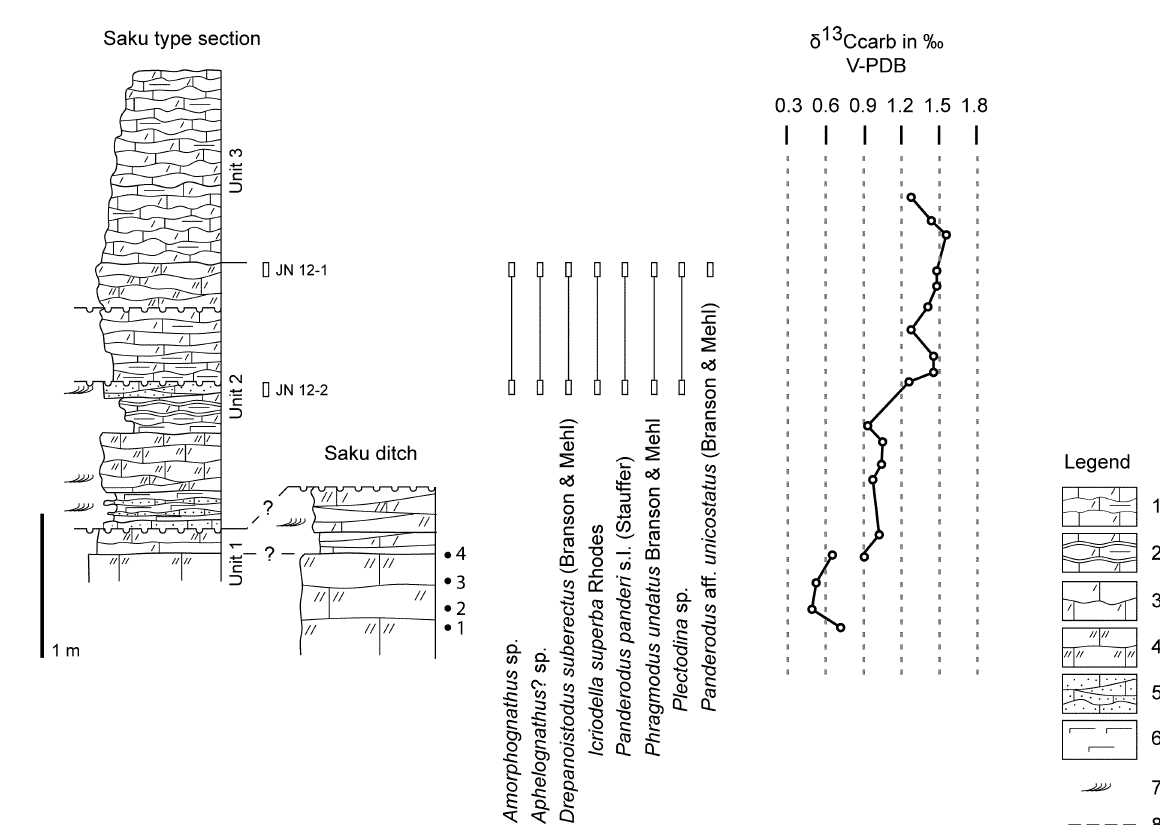
Fig. 4. General lithological logs of the type section of the Saku Member and a ditch in a deeper part of the same quarry. Right of the log positions of samples processed and ranges of conodonts identified are indicated. Legend: 1, argillaceous wackestone; 2, intercalation of argillaceous wackestone and marlstone; 3, mainly fine-grained wackestone(cid:150)packstone; 4, coarse-grained packstone(cid:150) grainstone; 5, irregularly bedded siltstone(cid:150)fine-grained sandstone; 6, marlstone; 7, cross-bedding; 8,